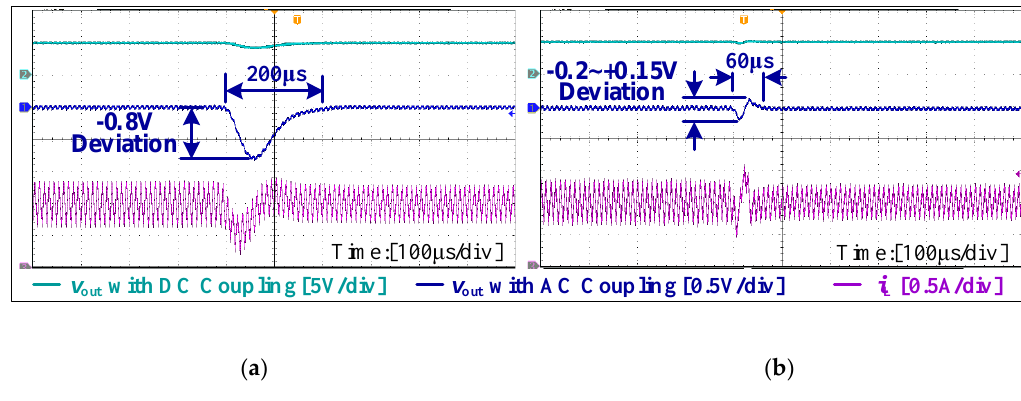
Figure 20. Transient voltages and current when v in steps from 12 to 9.5 V: ( a ) Digital current mode control with PID compensation and ( b ) DPVP control.